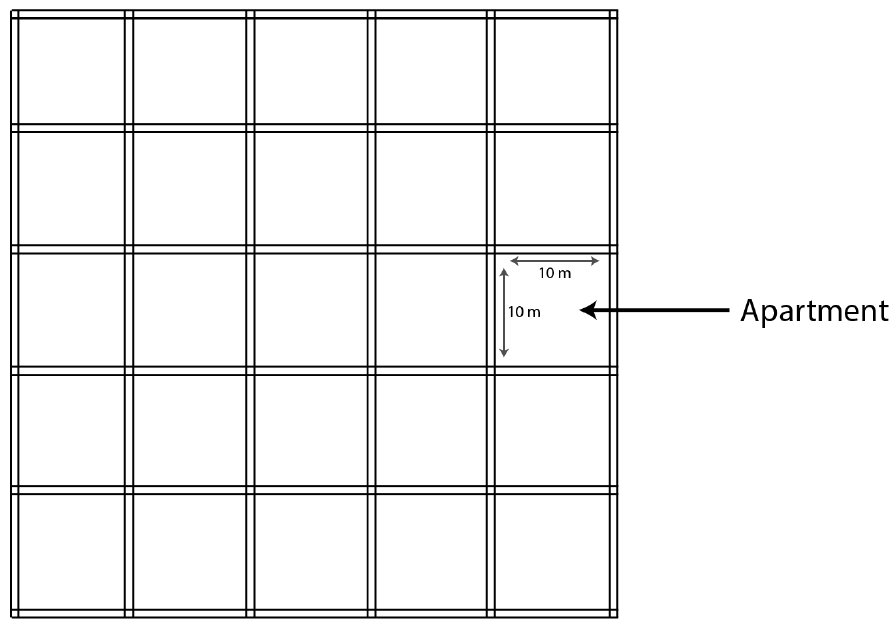
Figure 3. 5 × 5 grid model, reproduced from [38]. Table 7. Simulation